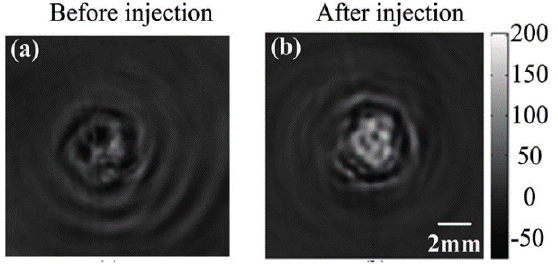
Figure 8. Thermoacoustic CT of tumor bearing mouse before injection of NMG 2 [Gd(DTPA)] ( a ) and after in situ injection of NMG 2 [Gd(DTPA)] ( b ). (Reprinted from reference [4]. Copyright with permission from © 2012 American Institute of